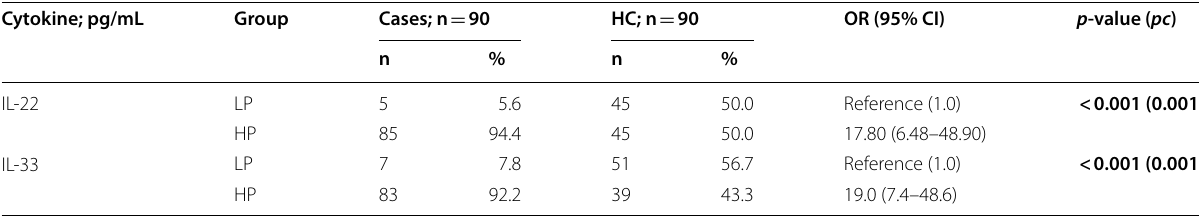
IL Interleukin, LP Low-production ( control median), HP High-production (> control median), HC Healthy controls, OR Odds ratio, CI Confidence interval, p : Two-tailed ≤ probability, pc : Bonferroni correction probability (significant p -value is indicated in